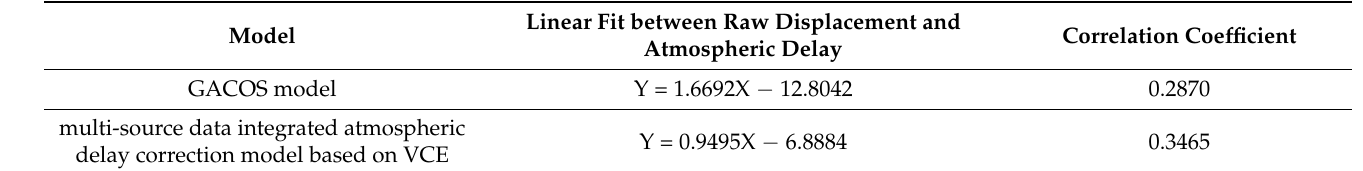
Table 1. Performance indicators for the GACOS model and the atmospheric delay correction model based on the VCE correlation coefficients.